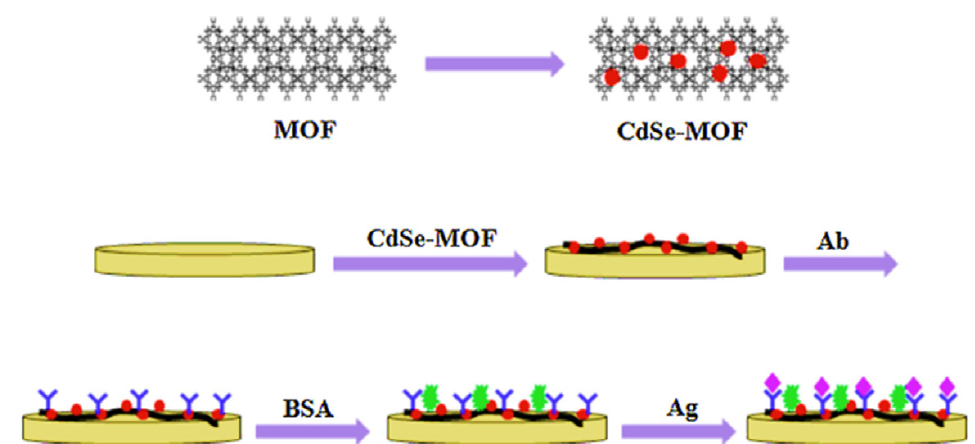
Fig. 5. The fabricating steps of the ECL immunosensor. Reproduced with permission from reference [52], copyright (2017) ELSEVIER.